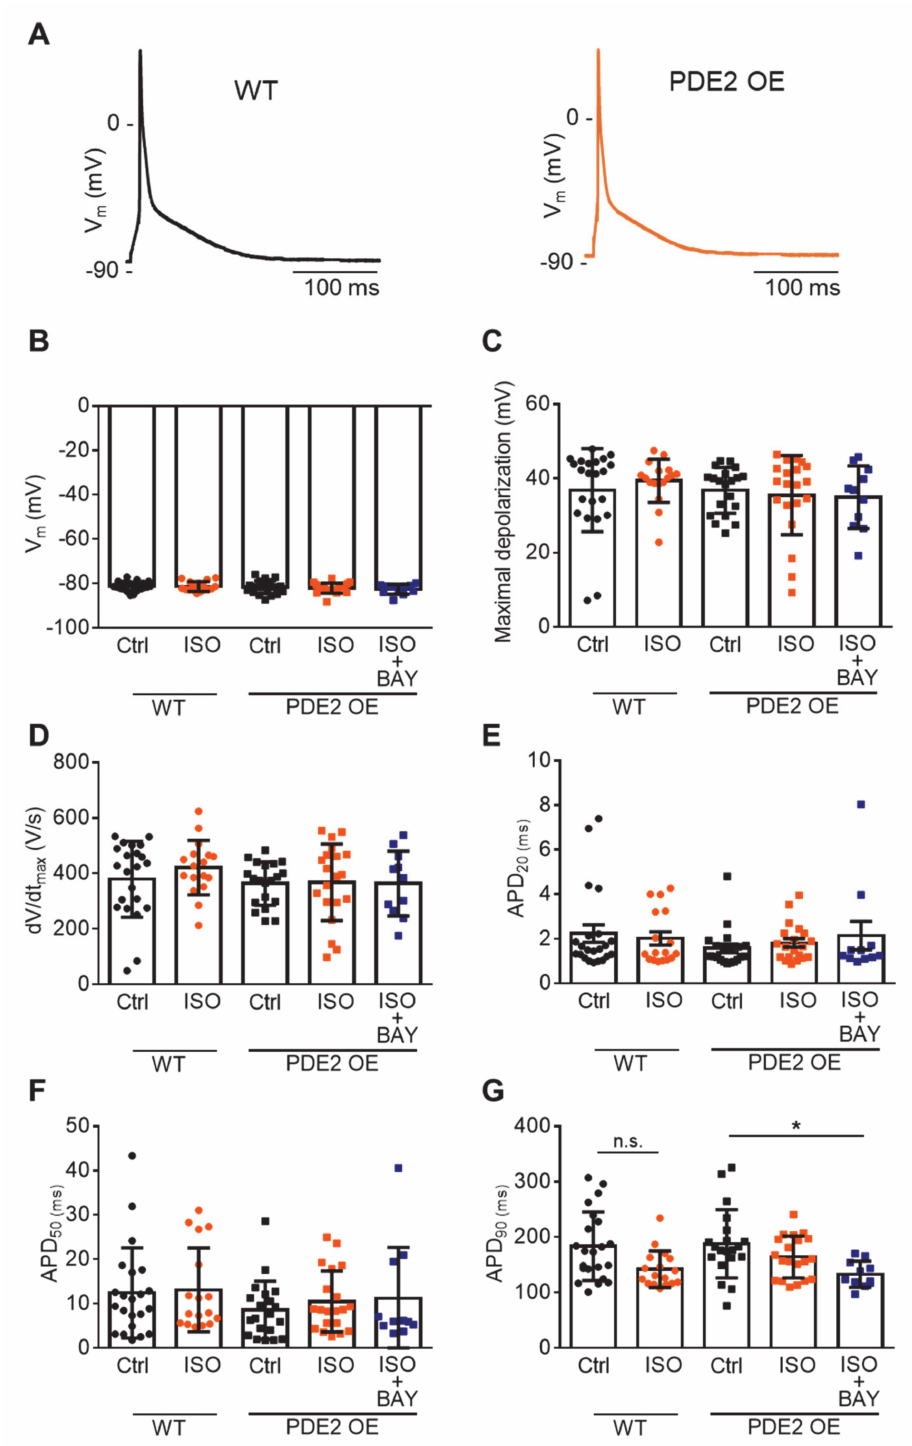
Figure 2. Similar basal action potential properties in PDE2 OE and WT. ( A ) Representative voltage traces of action potentials (AP) at 1 Hz from left ventricular myocytes of WT (circles) and PDE2 OE (squares) mice under basal conditions (Ctrl, black symbols) and upon β -adrenergic stimula- tion with isoprenaline (ISO, 100 nM, 10 min, orange symbols) and simultaneous PDE2 inhibition with BAY60-7550 (BAY, 100 nM, dark blue symbols). ( B ) Average resting membrane potential V m (mV), ( C ) maximum depolarization potential (mV), ( D ) maximal upstroke velocity dV/dt (V/s), ( E – G ) action potential duration at 20%, 50%, and 90% repolarization (APD 20 , APD 50 , APD 90 ). n.s. not significant, * p < 0.05 (N = 8 animals/genotype, 11 ≤ n ≤ 22